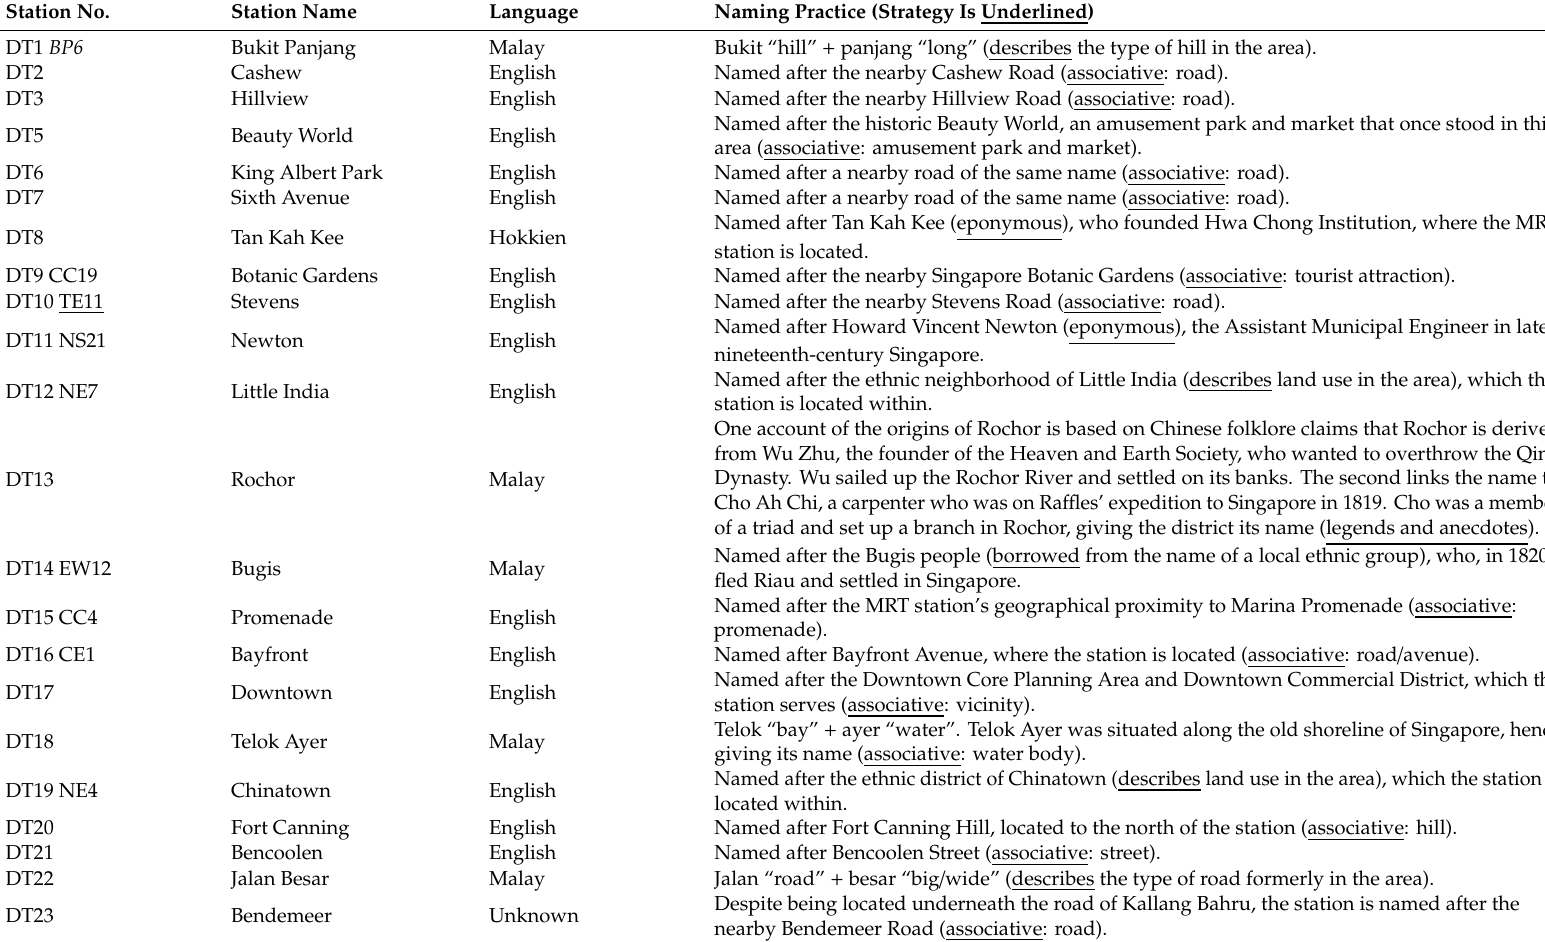
Table A2. Analysis of MRT Stations on the Downtown